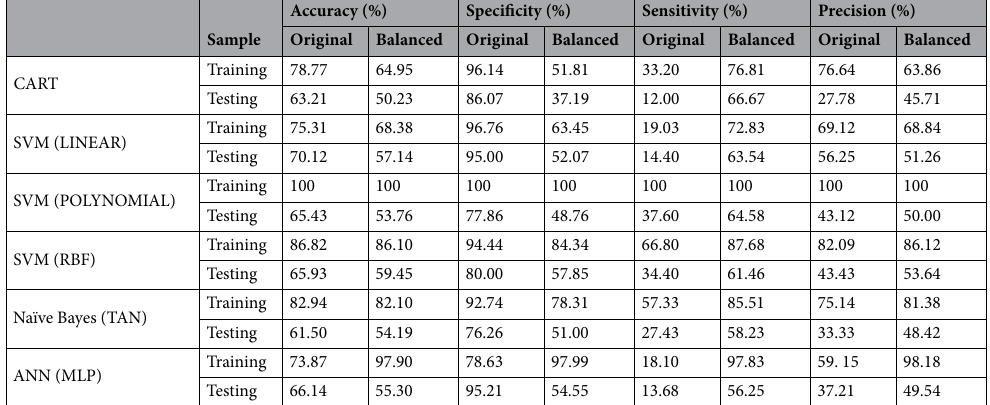
Table 2. Model evaluation (performance comparison) results-original and balanced data. a = Original data (Yes: 372(28.62%), No = 928(71.38%), b = Balanced Data (Yes = 372(50.1%), No = 370 (49.9%)).